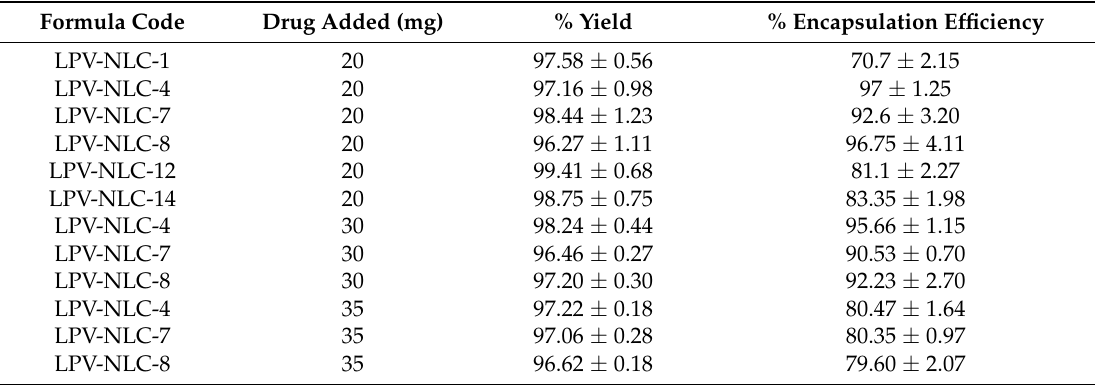
Table 3. Yield and entrapment efficiency of selected LPV-loaded NLCs